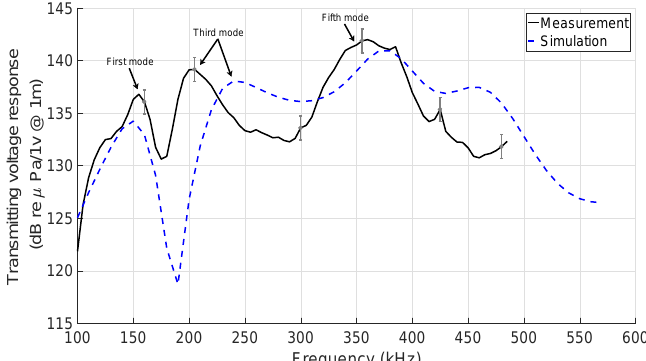
Figure 15. The measured and simulated transmitting voltage response (TVR) with respect to the frequency (Frequency response) of the transducer, which shows the first, second, and higher mode of vibrations.